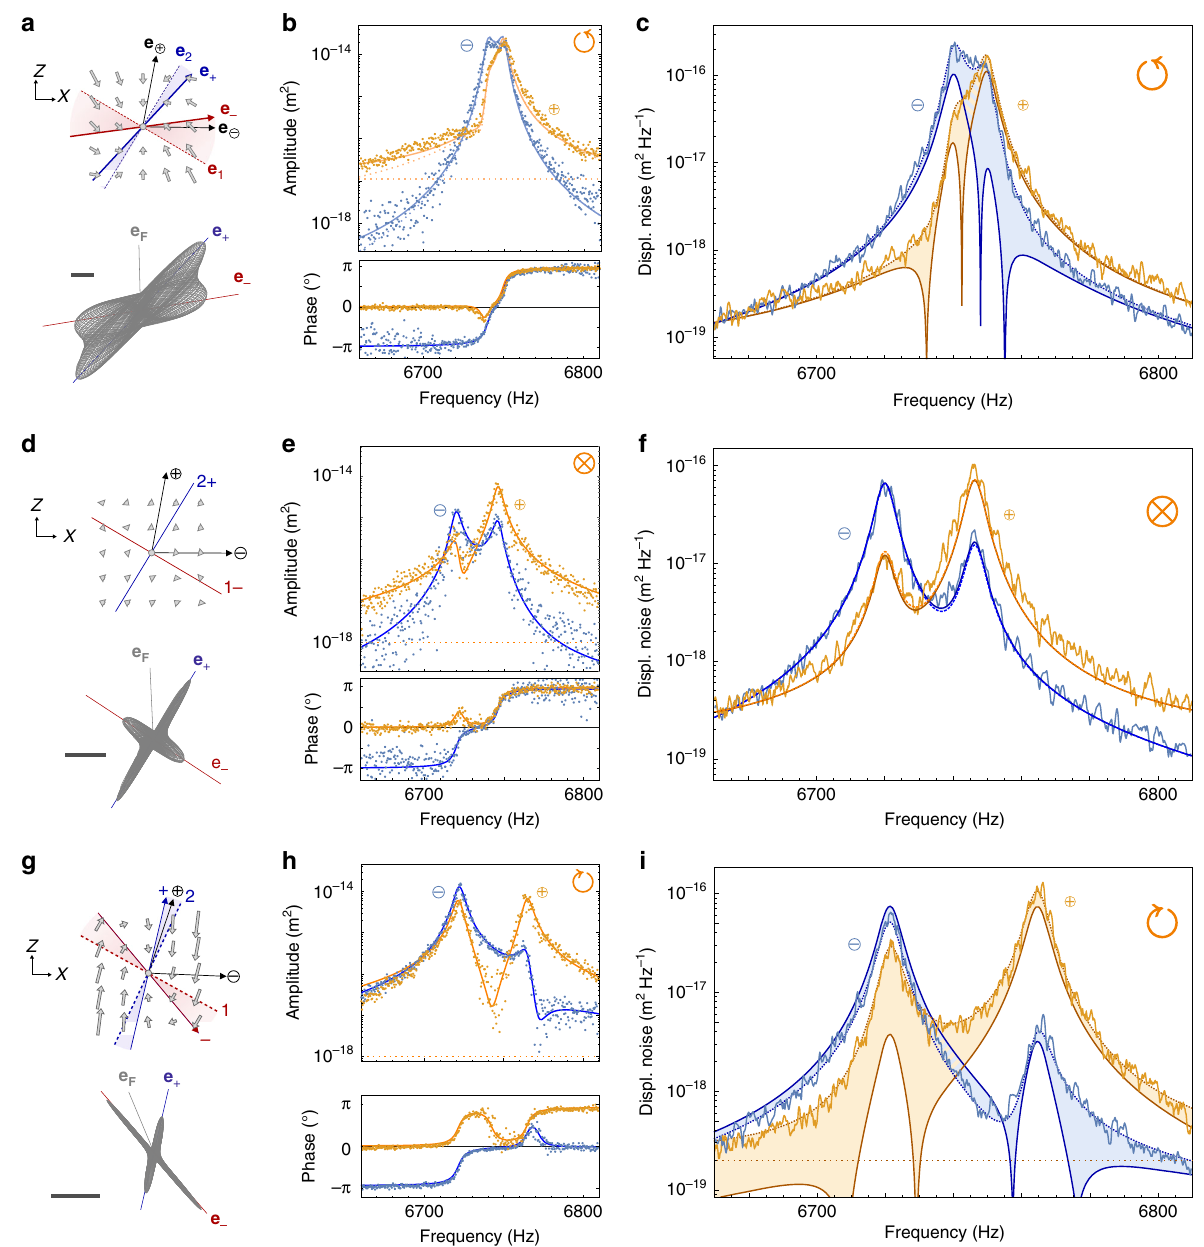
Fig. 3 Deviation from the fl uctuation-dissipation relation. a Spatial structure of the optical force fi eld at built from the force gradients deduced from thermal noise analysis for 63 μ W of pump power (100 nm scalebar). The 2D representations of the driven trajectories are built from the response measurements – amplitude and phase – on each readout channel ( (cid:2) ; (cid:3) ) obtained from one single frequency sweep and shown as dots in b . c Corresponding thermal noise spectra (solid light lines) measured on each channel, jointly fi tted (dashed lines) to estimate the g ij parameters. The values of the latter were then fi xed to fi t the response measurements (solid lines in b ) with the actuation amplitude (found to amount to 270aN) and direction (represented as e F in and χ a ) as only free parameters. This fi tting step completed the determination of the susceptibility matrix whose particular uniaxial components χ (cid:2)(cid:2) (cid:3)(cid:3) were injected in the second member of Eq. (3) to compute the thermal noise spectra expected from the FDR (solid dark lines on c ). Pronounced discrepancies (>10 dB) between these estimates derived from the fl uctuation dissipation relation and the direct experimental traces are emphasized as colored areas. Panels d – f are taken in position ⊗ at low optical power (2 μ W) where the shear force fi eld gradients can be neglected. There the measured spectra are in excellent agreement with the prediction of the fl uctuation dissipation relation. Panels g – i are taken on the other side of the optical axis () with an opposite rotational where no frequency merging occurs, see Supplementary Note 2. A similar substantial deviation is Strikingly, as shown in Fig. 4a (gray curves), a drive vector be obtained for a drive applied perpendicularly to the other ¼ θ (cid:10) þ π = 2 (see Supplementary Note 5). In almost perpendicular to e − can generate a signi fi cant displace- eigenmode: θ ± opt F ment along e + , larger than the one obtained with a drive vector absence of perpendicularity breaking, one recovers the intuitive aligned with e + (blue curve). Indeed, the maximum resonantly result that the drive of one eigenmode is most ef fi cient if it is driven displacement along one eigenmode orientation is shown to applied in the direction of this eigenmode. The counter-intuitive